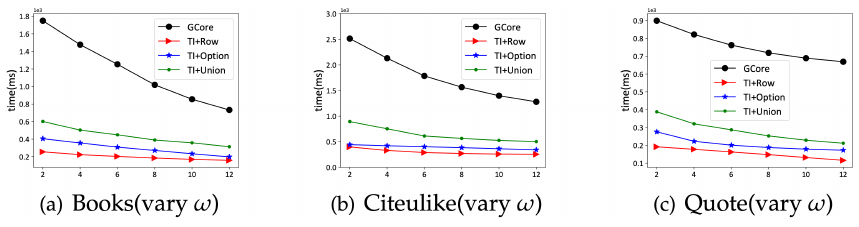
Figure 7. Effect of ω in ( k , ω ) -core